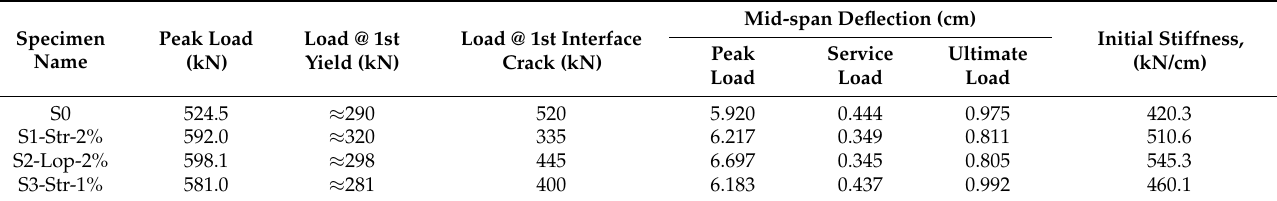
Table 5. Summary of Key Experimental Test